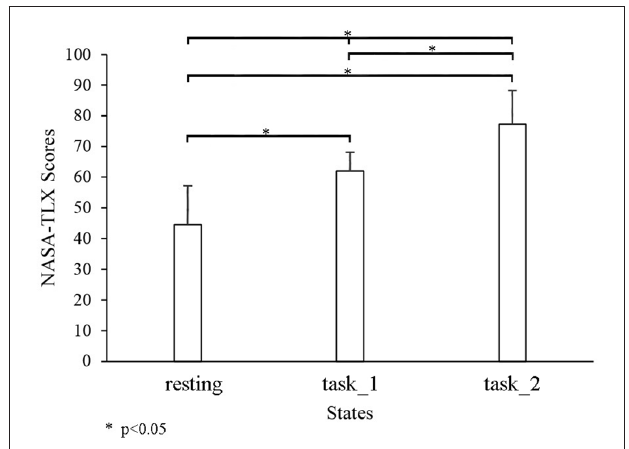
FIGURE 3 | Comparison of the NASA-task load index (TLX) among three states. “ ∗ ” Indicates a statistically significant change.